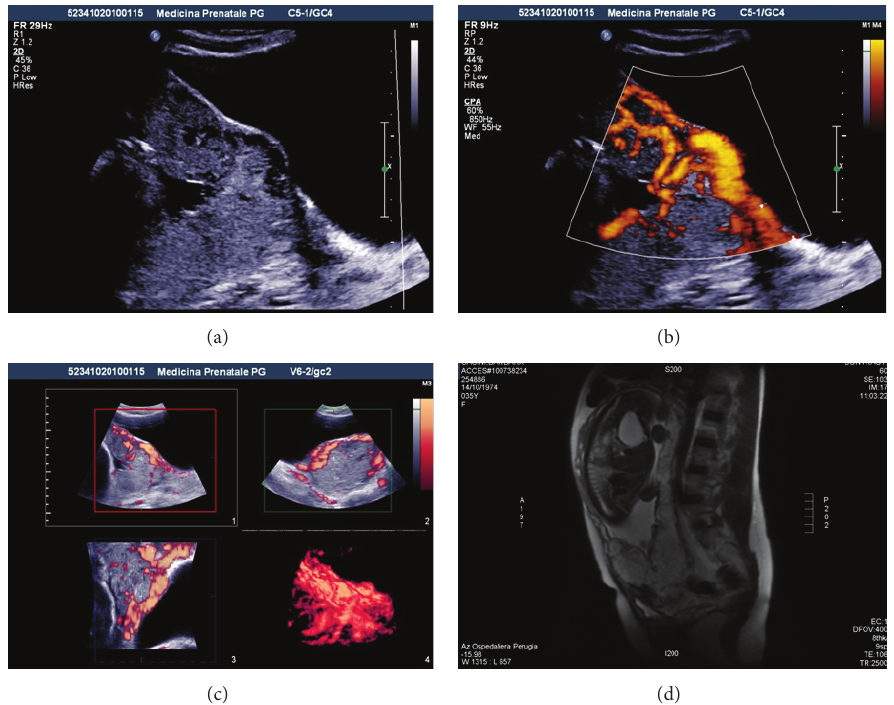
F 1: Ultrasonographic-RMN diagnosis of placenta previa accrete. (a) 2D transabdominal ultrasound showed the absence of placental- miometral interface, the uterine wall being undistinguishable from the placenta, and the presence of multiple vascular intraplacental lacunae “Swiss cheese placental appearance,” (b) 2D color Doppler ultrasound revealed an extensive vascularity along the anterior portion of the lower uterine segment and appears to extend up to and around the bladder, (c) 3-dimensional power Doppler showed the presence of numerous retroplacental vessel, and (d) pelvic magnetic resonance (MR) con�rmed the ultrasound diagnosis of placenta previa accreta with partial wall bladder